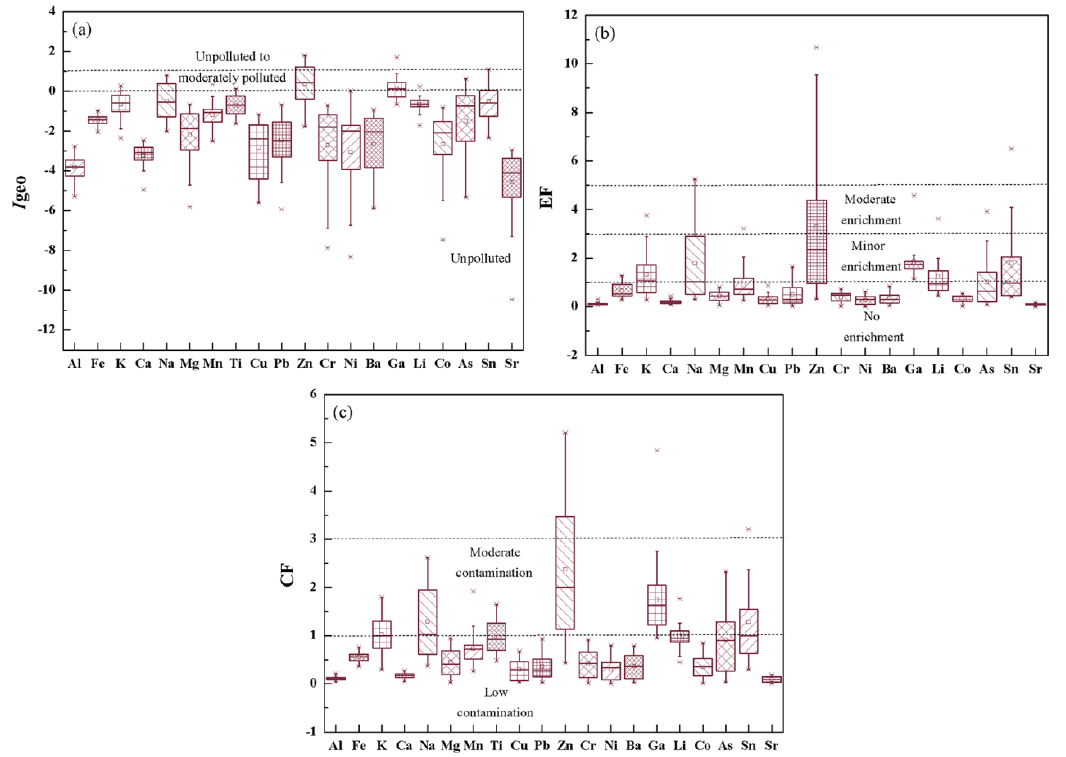
Figure 6. Box-plots of ( a ) geo-accumulation ( I geo ), ( b ) enrichment factor (EF) and ( c ) contamination factor (CF).